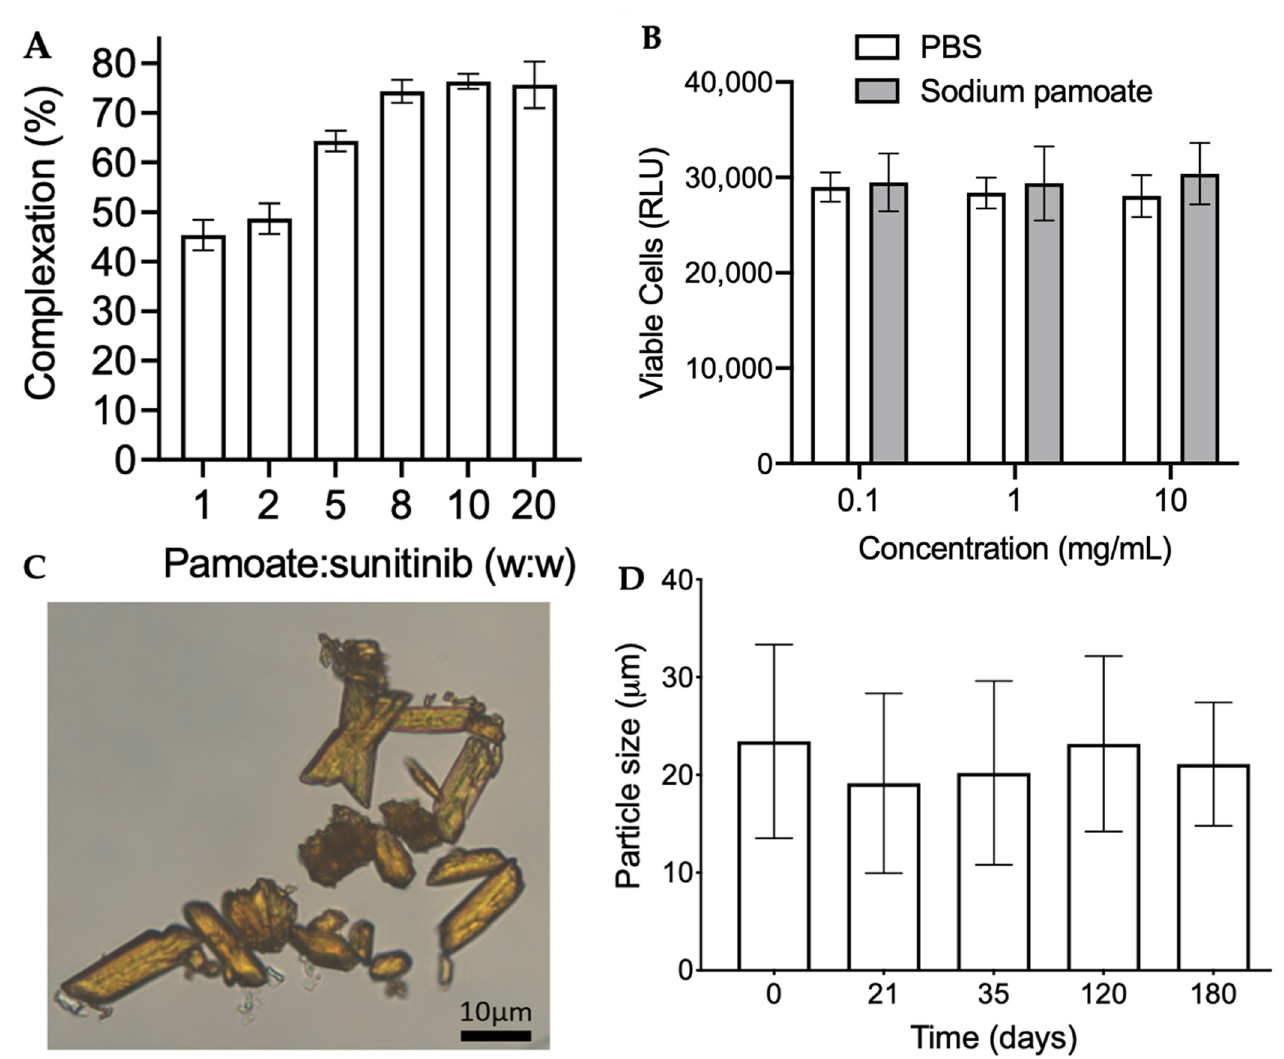
Figure 1. SPC microcrystal characterization. ( A ) Complexation efficiency of sunitinib malate when mixed at various ratios of pamoic acid to sunitinib ( n = 3). Data shown as mean ± SD. ( B ) Viability of primary mouse RGCs after treatment with sunitinib malate (1 μ M) plus either sodium pamoate or PBS ( n = 3–5). Data represented as the mean ± SEM. ( C ) Representative microscopy image of SPC microcrystals. Scale bar = 20 μ m. ( D ) Volume mean size ( μ m) of SPC microcrystals over a period of 180 days at room temperature ( n = 3). Data shown as mean ± SD.